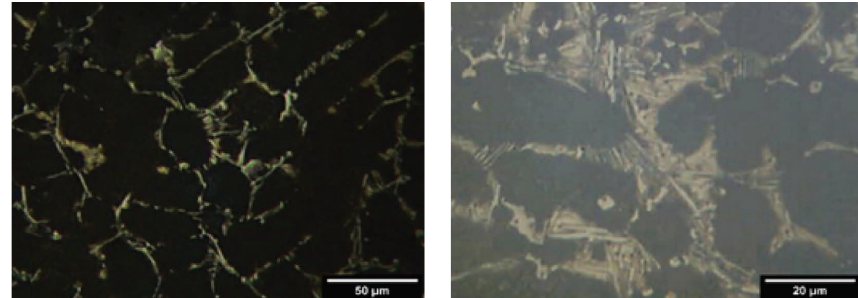
Figure 9: Microstructure of 4V-3W-HC steel in the as-cast condition.